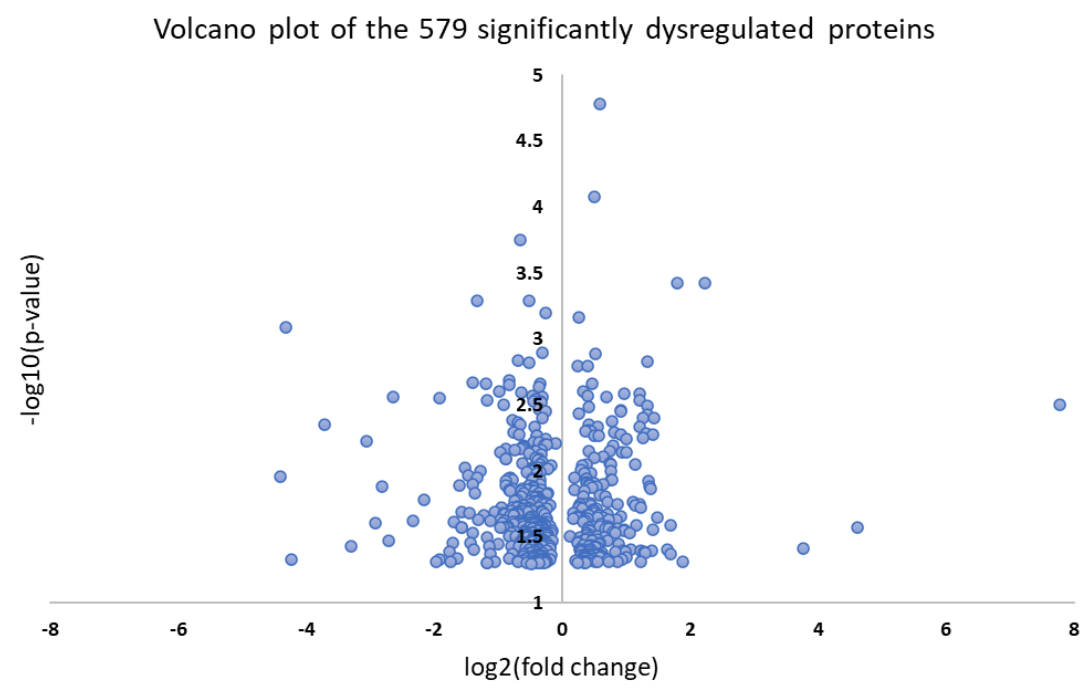
Figure A1. The volcano plot of proteins.